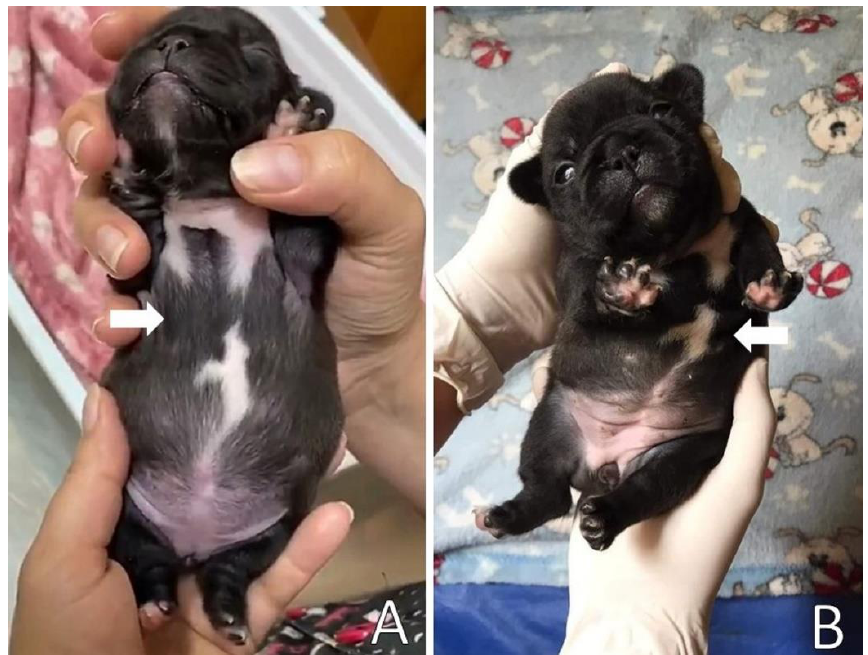
Figure 8. ( A ) Patient before splint management, presenting chest depression in the sternum bone region (arrow). ( B ) Patient after splint removal presenting chest with the absence of ventrodorsal narrowing in the sternal region (arrow) after noninvasive treatment.